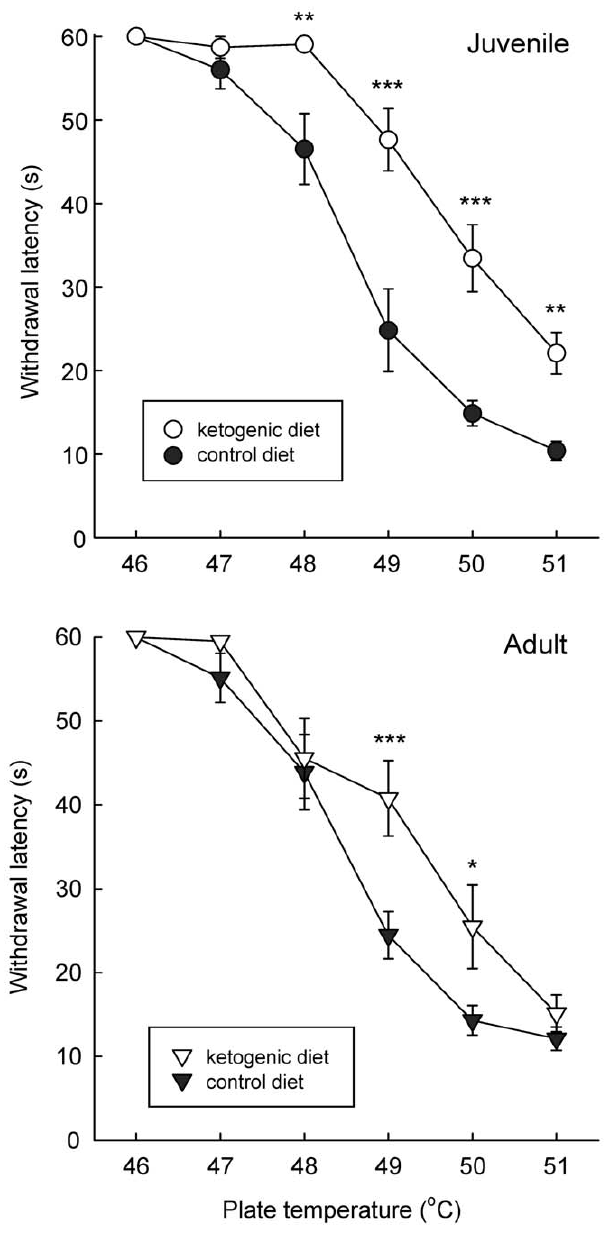
Figure 1. Hindpaw thermal nociception is decreased in juvenile and adult rats fed the ketogenic diet. Top: juvenile; Bottom: adult. All animals were tested on one temperature per day. Increasing hot plate temperature led to reduced withdrawal latency in all groups, and temperature-response curves were similar for juveniles and adults on the control diet (control diet – filled symbols, ketogenic diet – empty symbols). The ketogenic diet increased latencies in both age groups, with a more robust effect in juveniles. Analysis of juveniles revealed significant effects of temperature (F=100.7, p , 0.001) and diet (F=18.9, p , 0.001), and a significant diet x temperature interaction (F=7.1, p , 0.001). Analysis of adults revealed significant effects of temperature (F=101.0, p , 0.001) and diet (F=4.8, p , 0.05), and a significant diet x temperature interaction (F=2.7, p , 0.05). Numbers of subjects: 12 for each juvenile group, 14 for adult control diet, 16 for adult